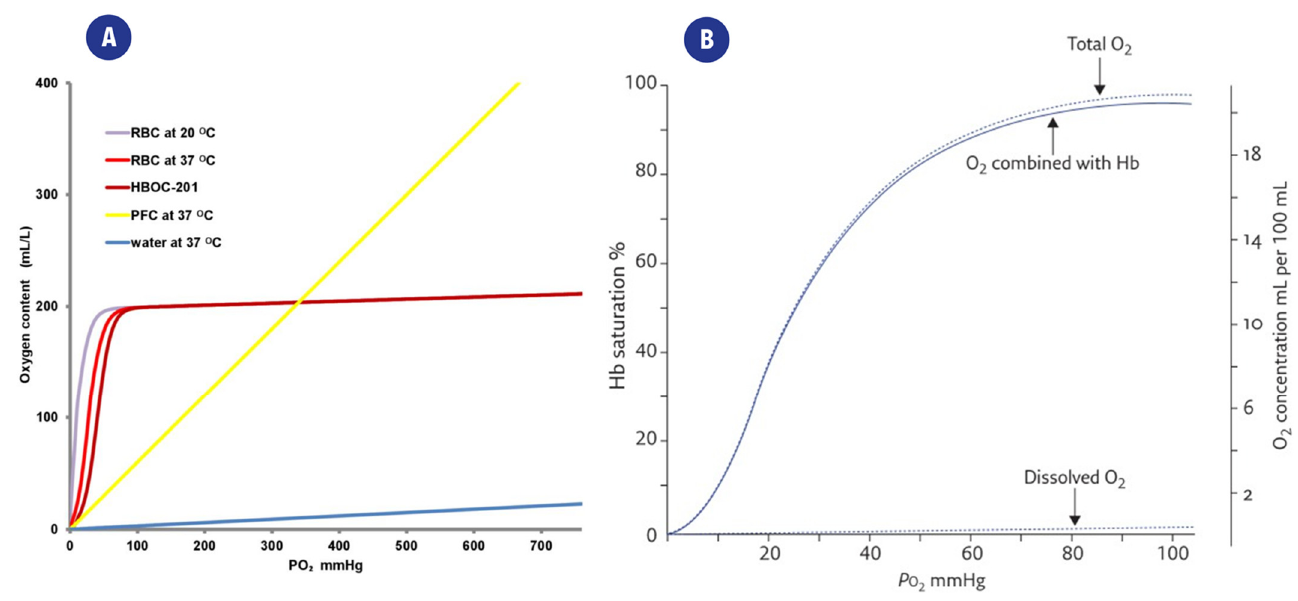
Figure 2. ( A ). Representation of the relation between partial oxygen pressure(pO 2 ) and the C O2 content of different solutions. O2 is poorly dissolved in water (blue curve), while the presence of carriers such as red blood cells (RBC), perfluorocarbons (PFC), or a hemoglobin-based oxygen carrier (HBOC-201) greatly improves the C O2 of the fluid. From [21] ( B ). Typical “dissociation curve” describing the relationship between paO 2 and Hemoglobin saturation (Sa O2 ). The distribution of total DO in O 2 combined with heme and dissolved O 2 is also highlighted. From [26].